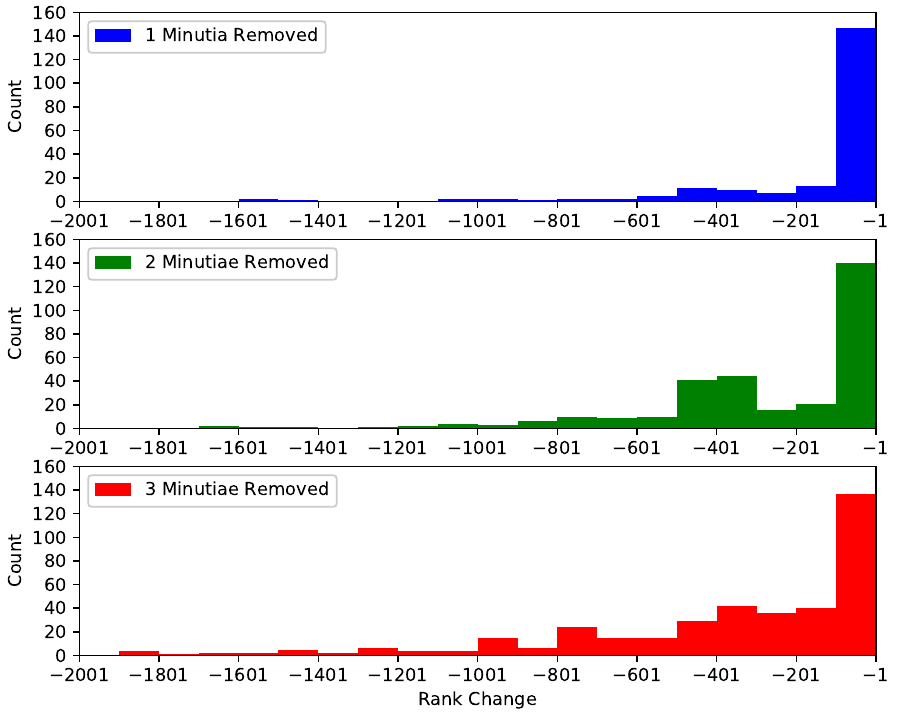
Figure 10. Histogram of rank loss for “lower” class regarding